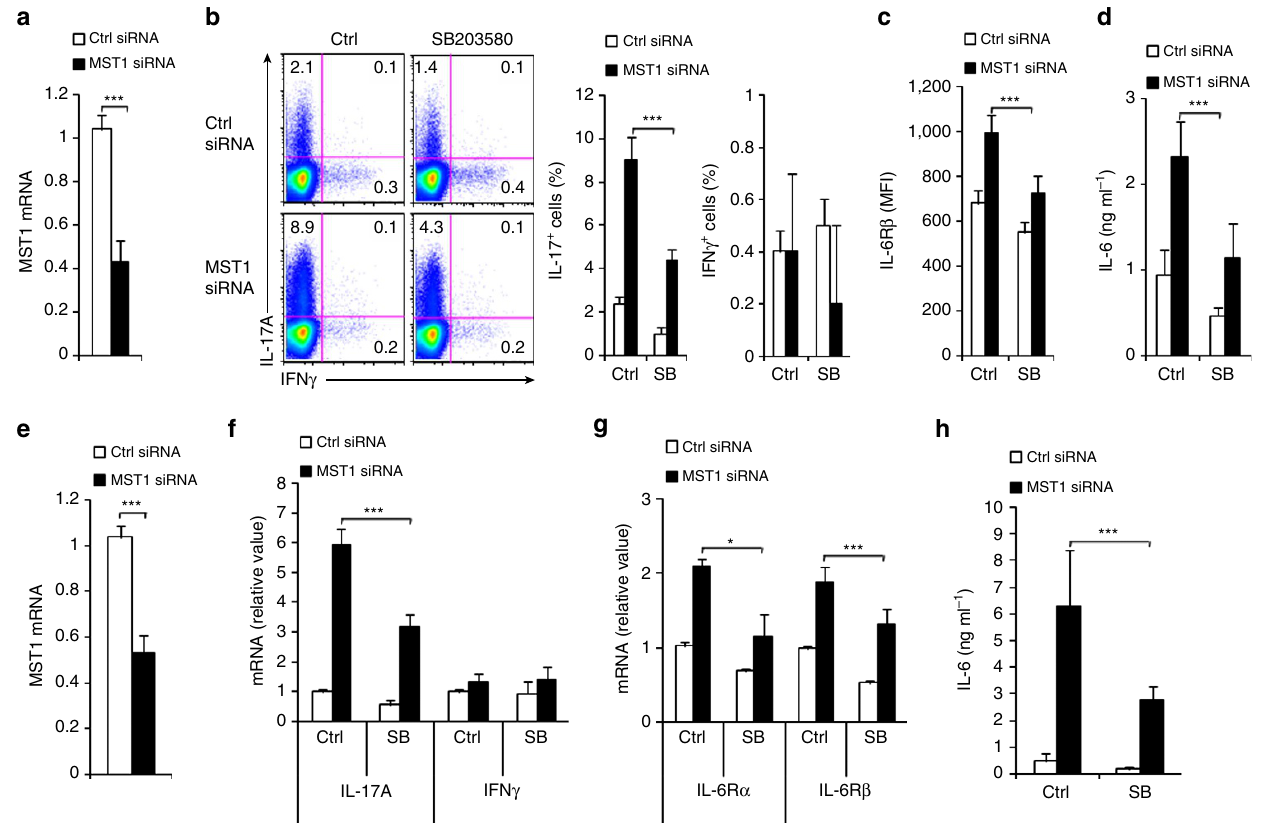
Figure 9 | Mouse and human DC MST1 modulates T-cell differentiation. Mouse ( a ) or human ( e ) DCs transfected with MST1-specfic or control siRNA and mRNA of indicated gene were determined with qPCR. Levels in the control groups were set to 1. Mouse DCs ( b – d ) or human DCs ( f – h ) pulsed with LPS (100ngml (cid:2) 1 ) were co-cultured with mouse or human T cells, respectively. The expression of IL-17 and IFN g in T cells was determined with FCM ( b ) or qPCR ( f ); MFI of the indicated gene in Tcells ( c ) and mRNA of the indicated genes in Tcells ( g ); the levels of IL-6 in the indicated supernatant ( d , h ) were determined. Data are representative of three independent experiments (mean ± s.d.; n ¼ 4–6). * P o 0.05 and *** P o 0.001, compared with the indicated groups. P -values were determined using Student’s t (Invitrogen). An ABI 7900 real-time PCR system was used for quantitative PCR (qPCR), with the primer and probe sets obtained from Applied Biosystems (Carlsbad, CA, USA).The primers used in the present study are listed in Supplementary Table 1. Results were analysed using SDS 2.1 software (Applied Biosystems). The cycling threshold value of the endogenous control gene ( Hprt 1, encoding hypoxanthine guanine phosphoribosyl transferase) was subtracted from the cycling threshold. The expression of each target gene is presented as the fold change relative to that of control samples 68 . Protein analysis . For detection of phosphorylated signalling proteins, purified cells activated with LPS (Sigma) were immediately fixed with Phosflow Perm buffer (BD Biosciences) and stained with PE or APC directly conjugated with an antibody to Erk phosphorylated at Thr202 and Tyr204 (clone 20A; BD Biosciences), p38MAPK phosphorylated at Thr180 and Thr182 (clone D3F9), JNK phosphorylated at Thr183 and Tyr185 (clone G9), STAT4 phosphorylated at Tyr701 and Ser727 (clone 58D6), STAT3 phosphorylated at Tyr705 (clone D3A7), AKT phosphorylated at Ser473 (clone D9E), AKT phosphorylated at Thr308 (clone D25E6), S6 Ribosomal Protein phosphorylated at Ser235/236 (clone D57.2.2E; all from Cell Signaling Technology and diluted at 1:100 in 2% bovine serum albumin), as described previously 16 . Immunoblot analysis was performed as described 68 The primary antibodies against MST1 (catalogue number 3682), NF-kB p65 (clone D14E12), p38MAPK (catalogue number 9212), p-p38MAPK (Thr180/Thr183; clone 3D7), p-MK2 (Thr334; clone 27B7), p-MSK1 (Thr581; catalogue number 9595), p-CREB (Ser133; clone 87G3), p-C/EBP b (Thr235; catalogue number 3084), p-c-Fos (Ser32; catalogue number 5348) and p-I k B a (Ser32; clone 14D4; all from Cell Signaling Technology and diluted at 1:1,000 in 2% bovine serum albumin) and along with an anti- b -actin (clone AC-15; Sigma-Aldrich; 1:2,000) antibody. Images have been cropped for presentation and full-size blot is shown in Supplementary Fig. 22.